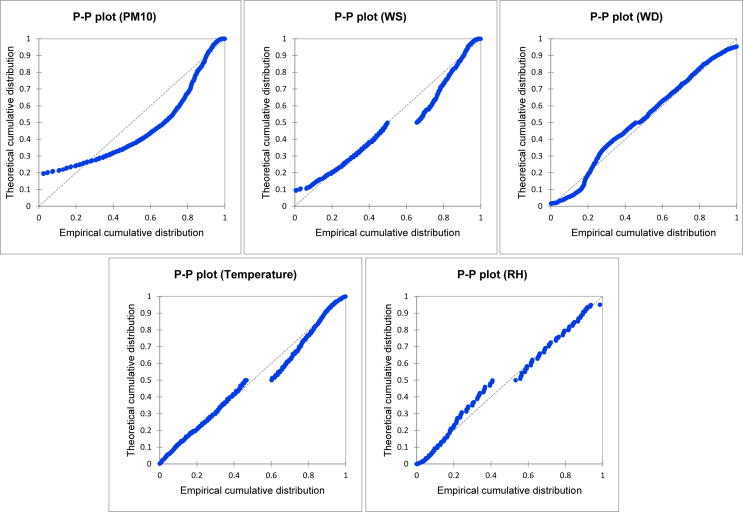
The normality test chart.